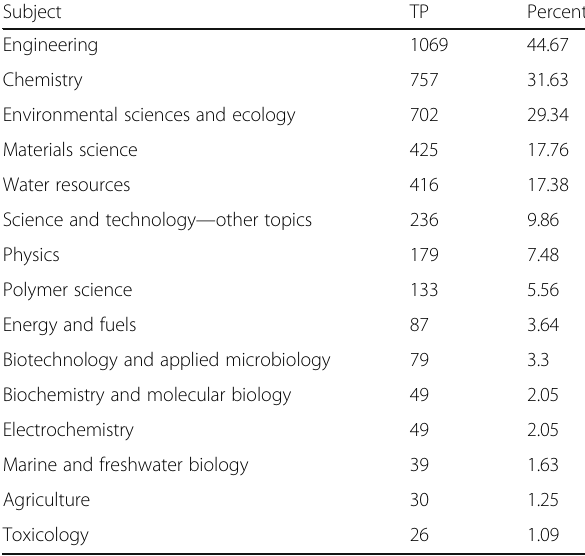
Table 3 The 15 most productive subjects during 1997 –